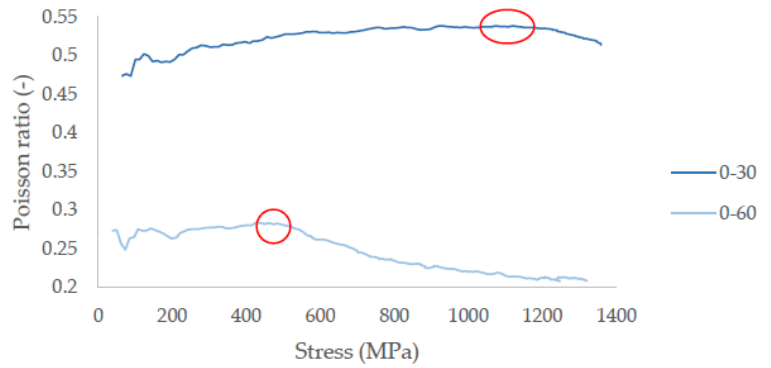
Figure 15. Evolution of the Poisson’s ratio of the angle-ply laminates.